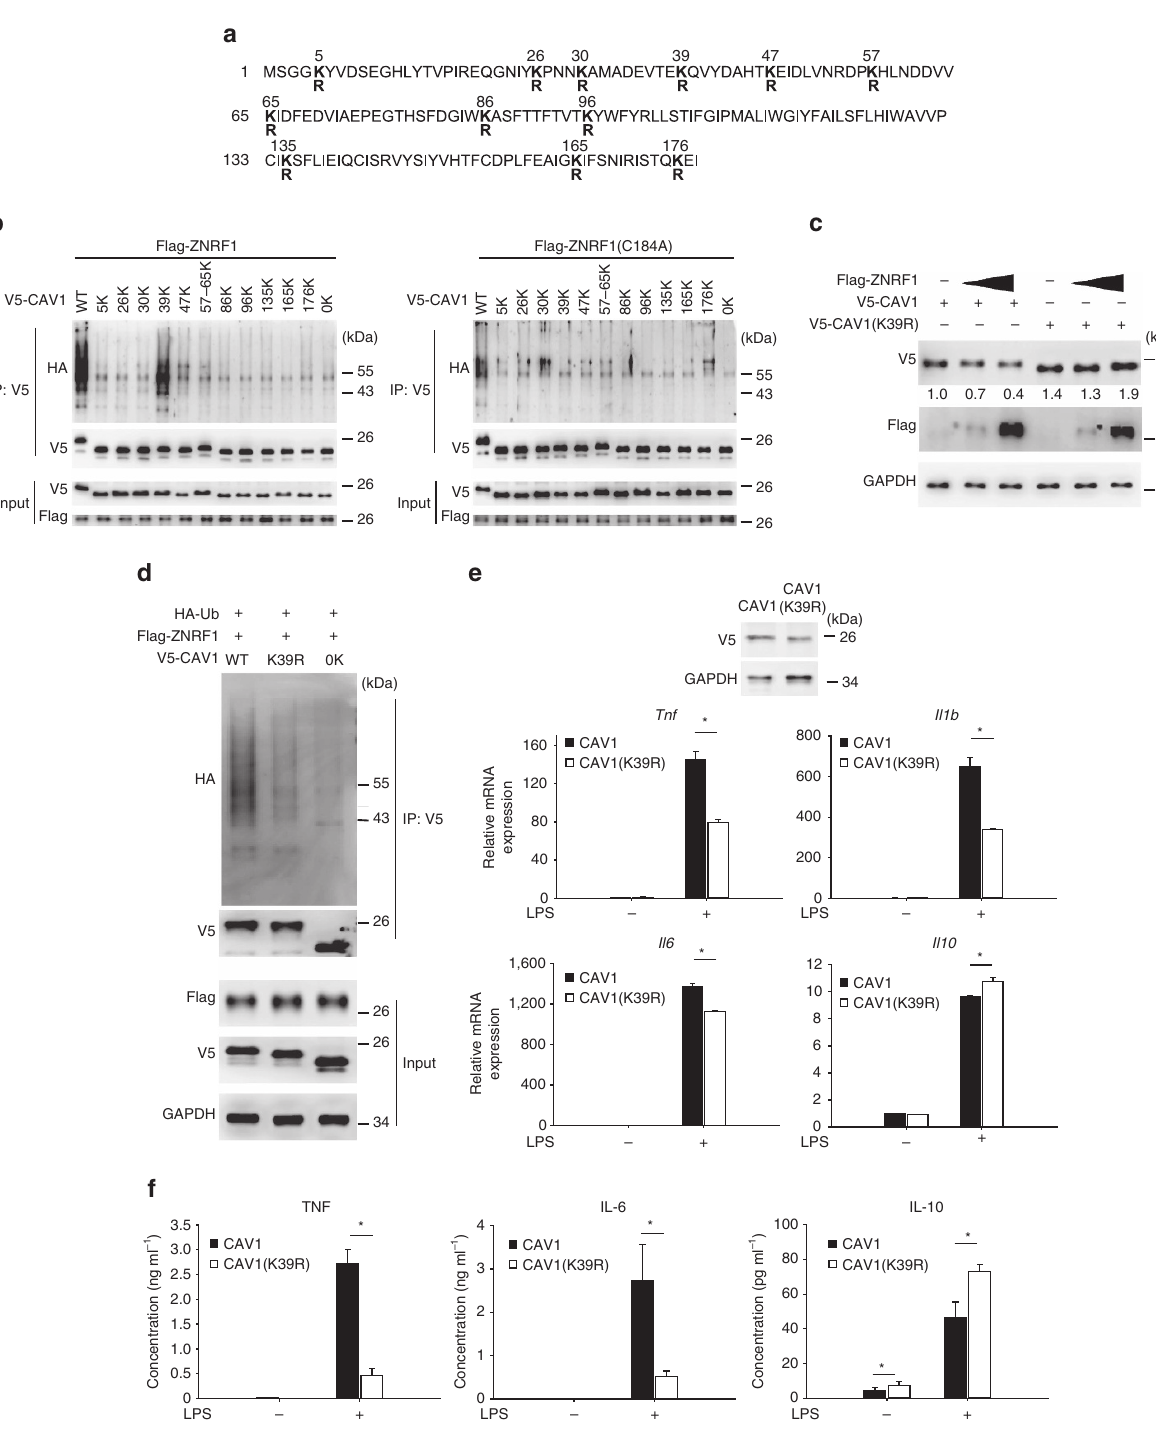
Figure 5 | ZNRF1 mediates CAV1 polyubiquitination at lysine 39 and promote CAV1 degradation to modulate TLR4-mediated immune response. ( a ) Schematic diagram of mouse CAV1 sequence and its 12 lysine residues, which were mutated to arginines. ( b ) HEK293Tcells were co-transfected with V5-tagged single-lysine CAV1 mutants and either Flag-ZNRF1 or ZNRF1(C184A) as indicated. CAV1 ubiquitination was determined by immunoprecipitating V5-CAV1 and immunoblotting with anti-HA. ( c ) Immunoblot analysis of V5-tagged CAV1 in lysates from HEK293Tcells expressing increasing amounts of ZNRF1 and either wild-type CAV1 or the CAV1(K39R) mutant as indicated. The intensities of the bands are shown as fold increases compared to those of control cells after normalization to GAPDH expression. ( d ) Immunoprecipitation of V5-tagged CAV1 proteins in lysates from HEK29Tcells expressing Flag- ZNRF1 and either V5-CAV1 or CAV1(K39R), followed by immunoblotting with anti-HA antibody. ( e , f ) Cav1 (cid:2) / (cid:2) BMDMs were reconstituted with either V5-CAV1 or CAV1(K39R) and treated with LPS (100ngml (cid:2) 1 ). ( e ) The mRNA expression levels of cytokines at 4h post LPS were analysed by RT-qPCR, and ( f ) cytokine levels in supernatants were detected by ELISA at 12h after LPS treatment. * P o 0.05 (Student’s t -test). The data are representative of three independent experiments performed in triplicate (error bars,